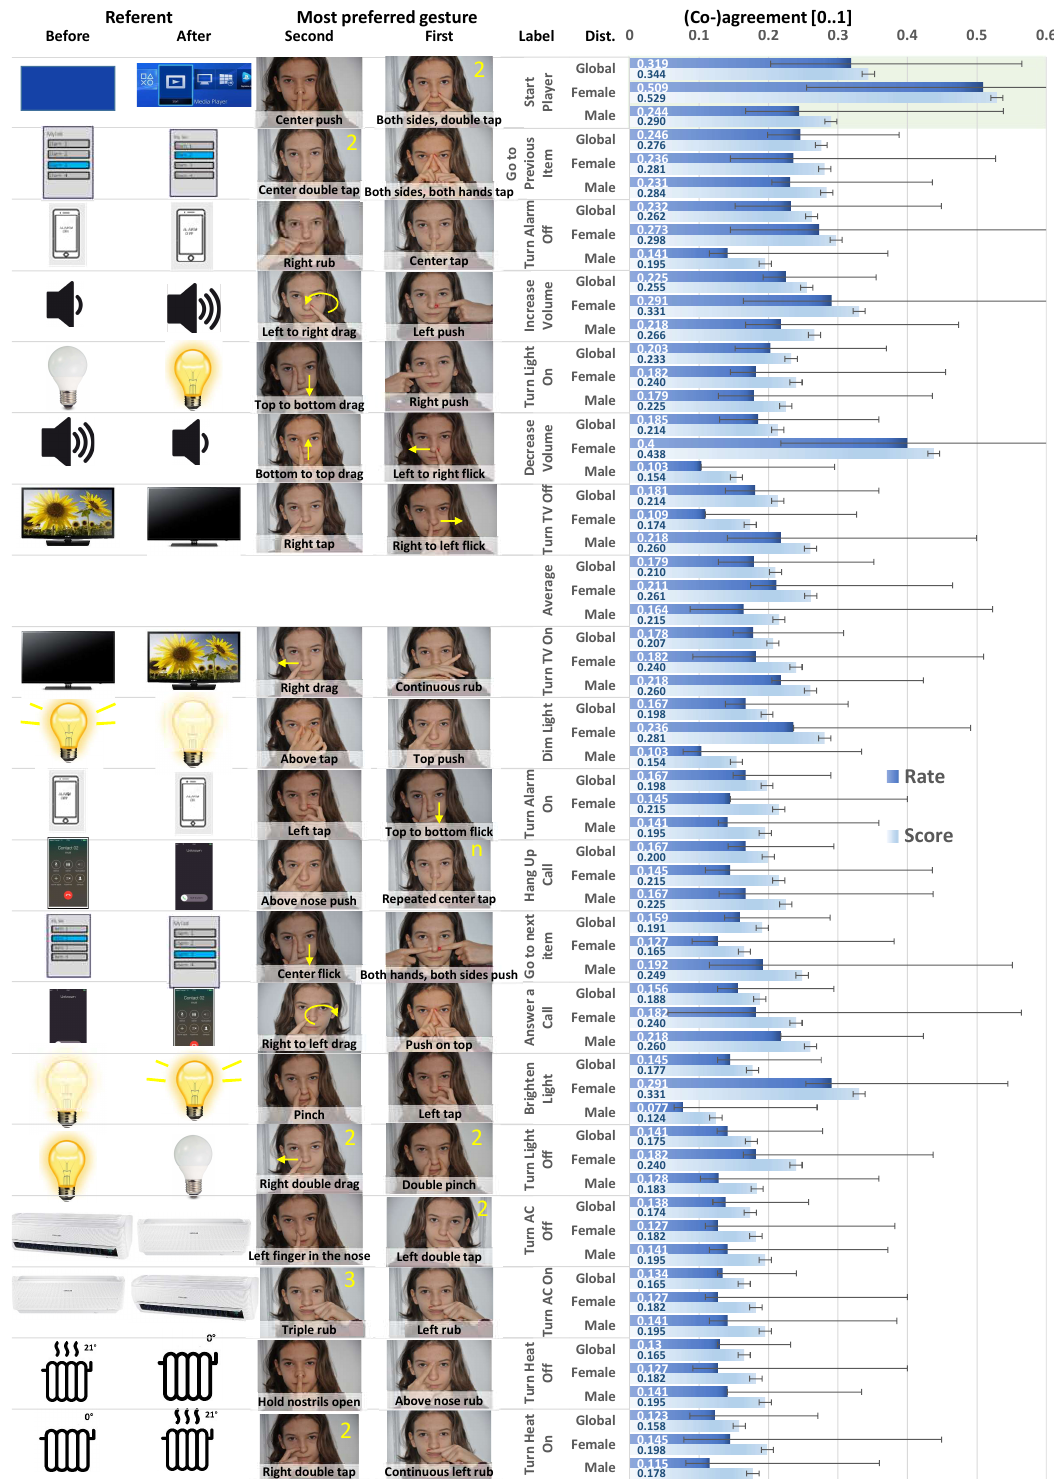
Figure 3. Co-agreement rates [51] agreement scores [8] by gender (global, male, and female) with the two most preferred gestures by referent, sorted in decreasing order of their co-agreement rate. Error bars show 95% confidence intervals ( α = 0.05 ) for the rates and standard errors for the